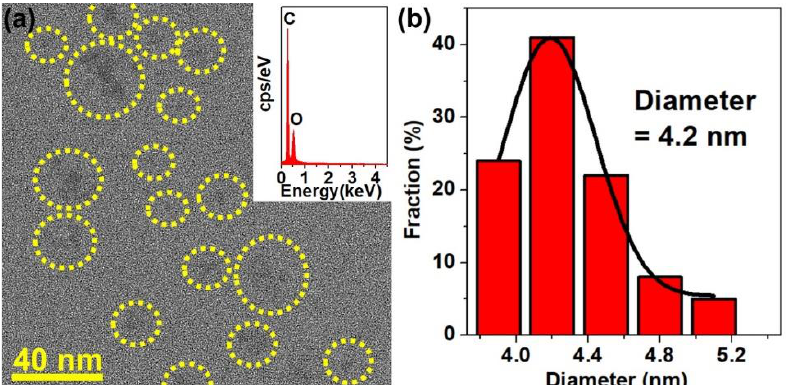
Figure 1. ( a ) TEM image of GQDs at low magnification. The inset shows the corresponding EDX spectrum. ( b ) The size-distribution histogram of GQDs. The solid line in the histogram represents a Gaussian fitting curve.